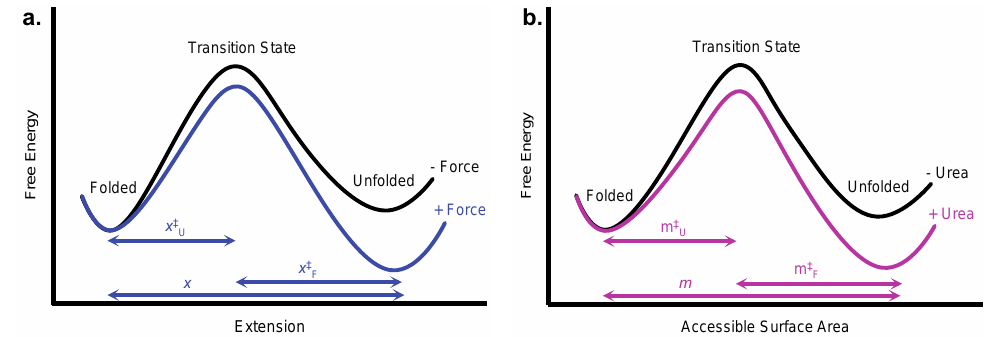
Figure 1. Effect of force and urea on a one-dimensional protein energy landscape. ( a ) Extension, which is related to the x- value, is the reaction coordinate determined from the effect of force on protein unfolding. Force preferentially lowers the free energy of more extended conformations like the transition state and the unfolded state. ( b ) Accessible surface area, which is related to the m -value, is the reaction coordinate determined from the effect of urea on protein unfolding. Urea preferentially lowers the free energy of conformations that expose more accessible surface area.